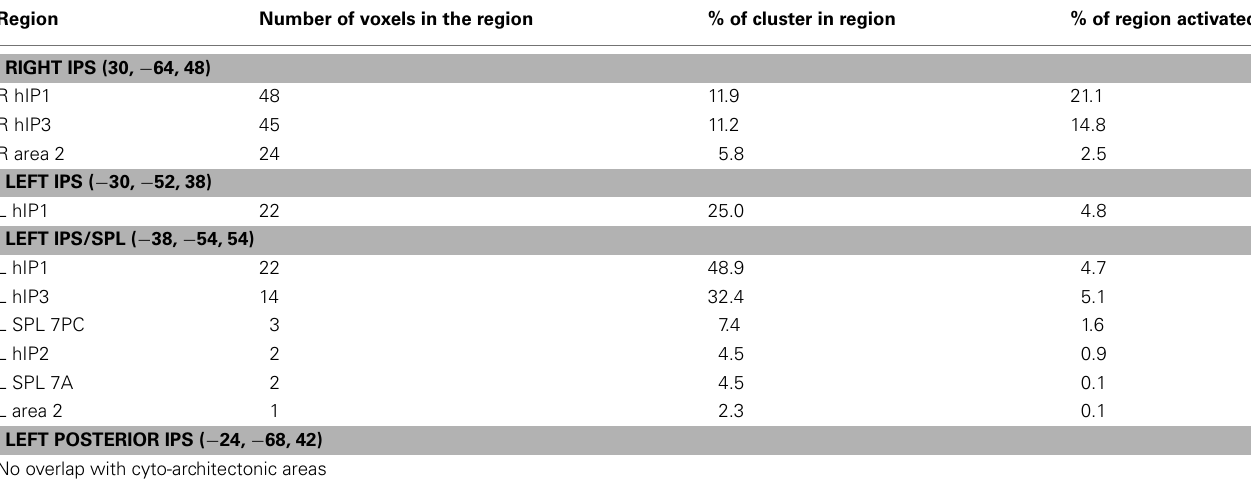
TableA2 | Parietal cortex regions that showed significantly greater activation for negative than positive problems and their relationship to cyto-architectonic maps of the parietal